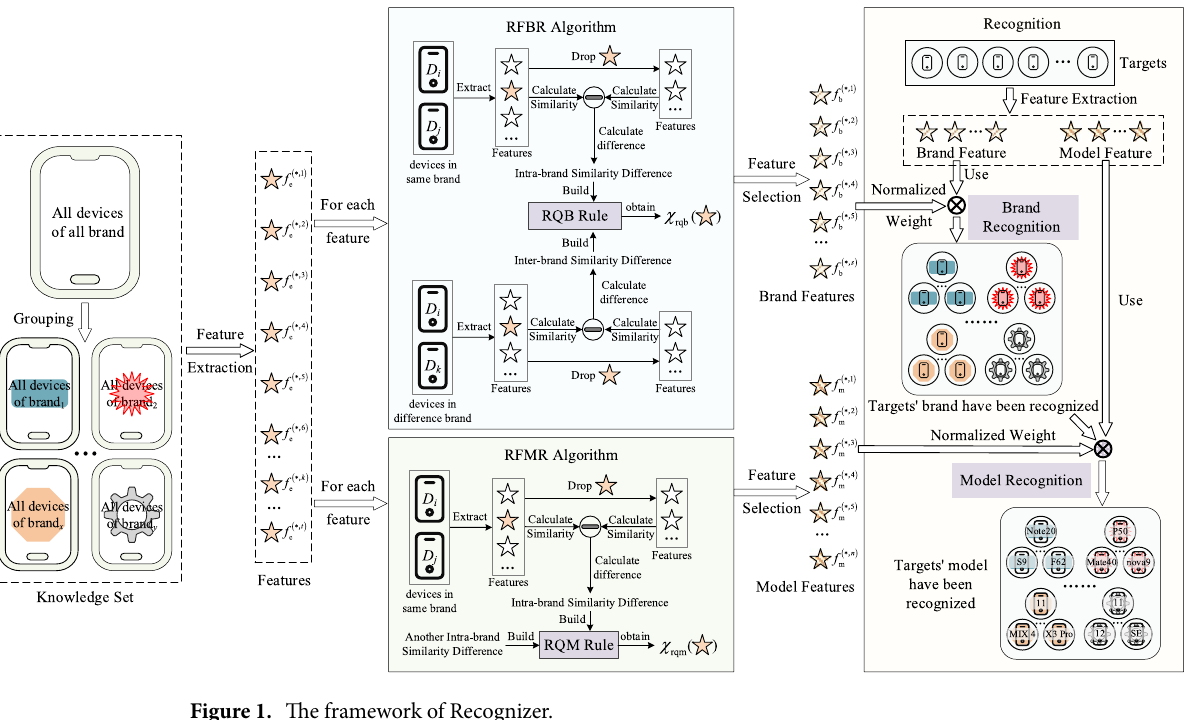
Figure 1. The framework of